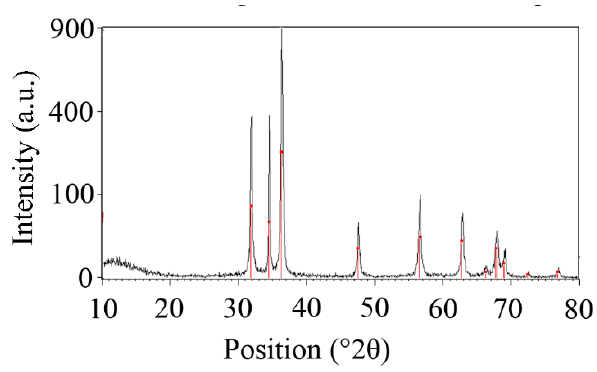
ff raction (XRD) pattern of the ZnO Figure 2 . X-ray powder diffraction (XRD) pattern of the ZnO nanorods. Figure 2 . X-ray powder diffraction (XRD) pattern of the ZnO nanorods. Figure 2. X-ray powder di